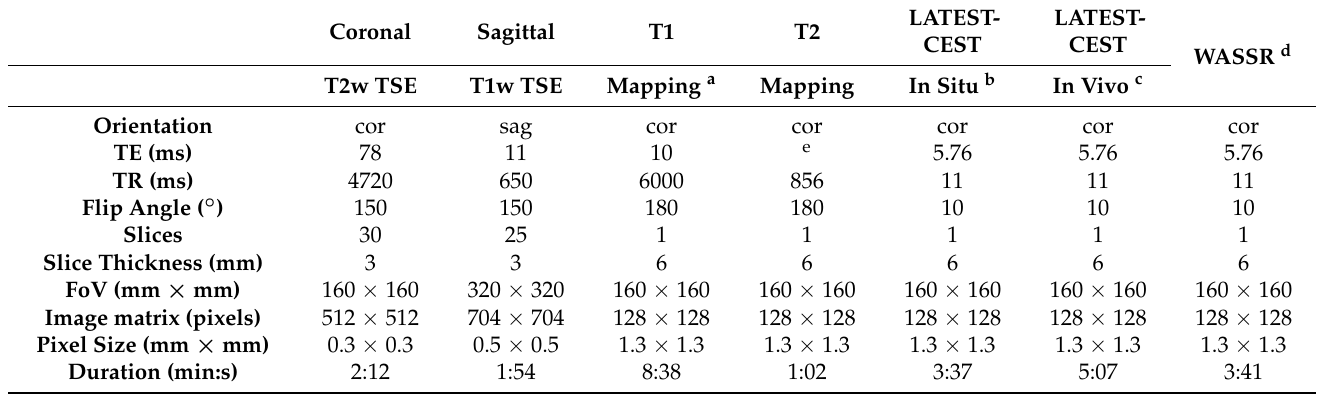
Table 1. Magnetic resonance imaging (MRI) acquisition